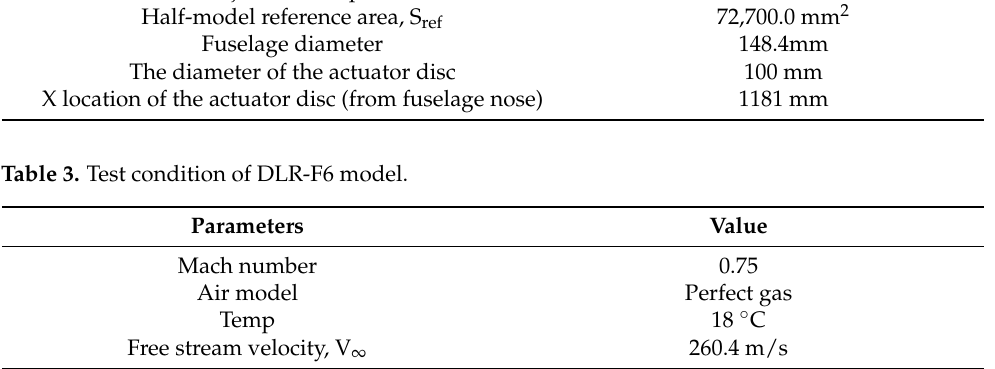
Table 3. Test condition of DLR ‐ F6 model.